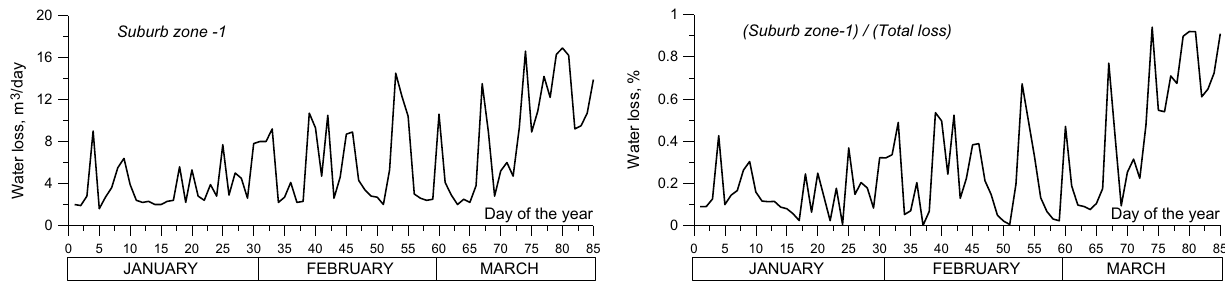
Fig. 6 Water losses in “Suburb-1” zone in m 3 (left), as percentage ( δ